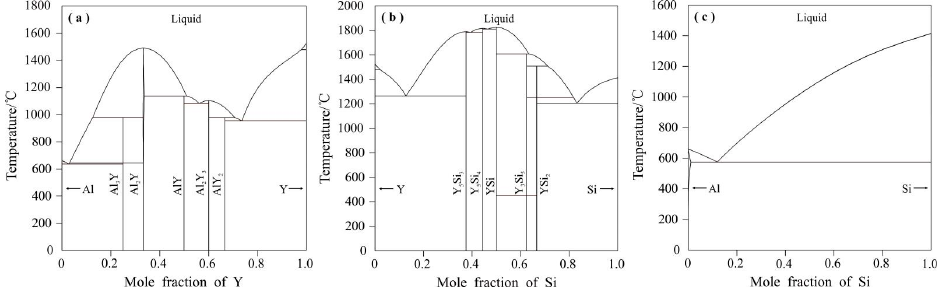
Figure 1. ( a ) The calculated phase diagram of the Al–Y system; ( b ) the calculated phase diagram of the Si–Y system; ( c ) the calculated phase diagram of the Al–Si system.